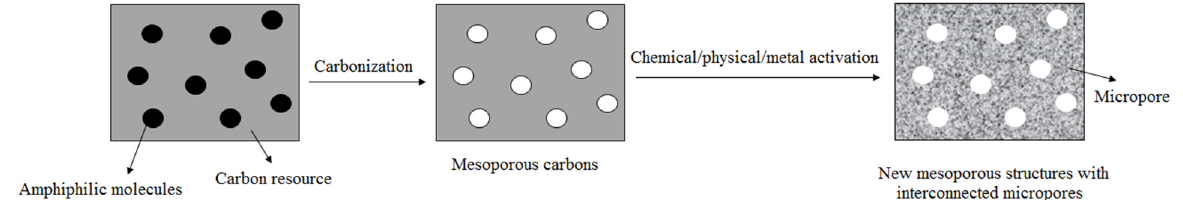
Figure 1. Schematic diagram of activation method for synthesis of porous carbon.